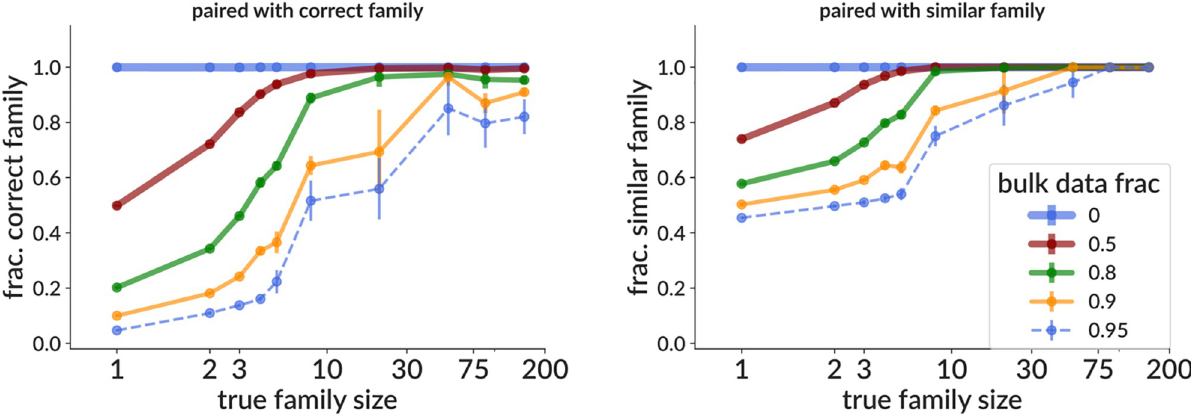
Fig 5. Effectiveness on simulation of the approximate bulk data pairing method as a function of true family size, shown as the fraction of sequences paired with a sequence from the correct family (but not necessarily the correct sequence, left) and the fraction paired with a family similar to the correct family (right). The method merges together a single cell and a bulk sample drawn from the same pool of B cells, and the “bulk data fraction” shows the fraction of this merged sample that stems from the bulk sample. “Similar” families are defined as families with true naive sequences separated by nucleotide Hamming distances of 3 or less. The fraction of sequences correctly paired, mispaired, and left unpaired are shown in S9 Fig. Other details same as in Fig 4.